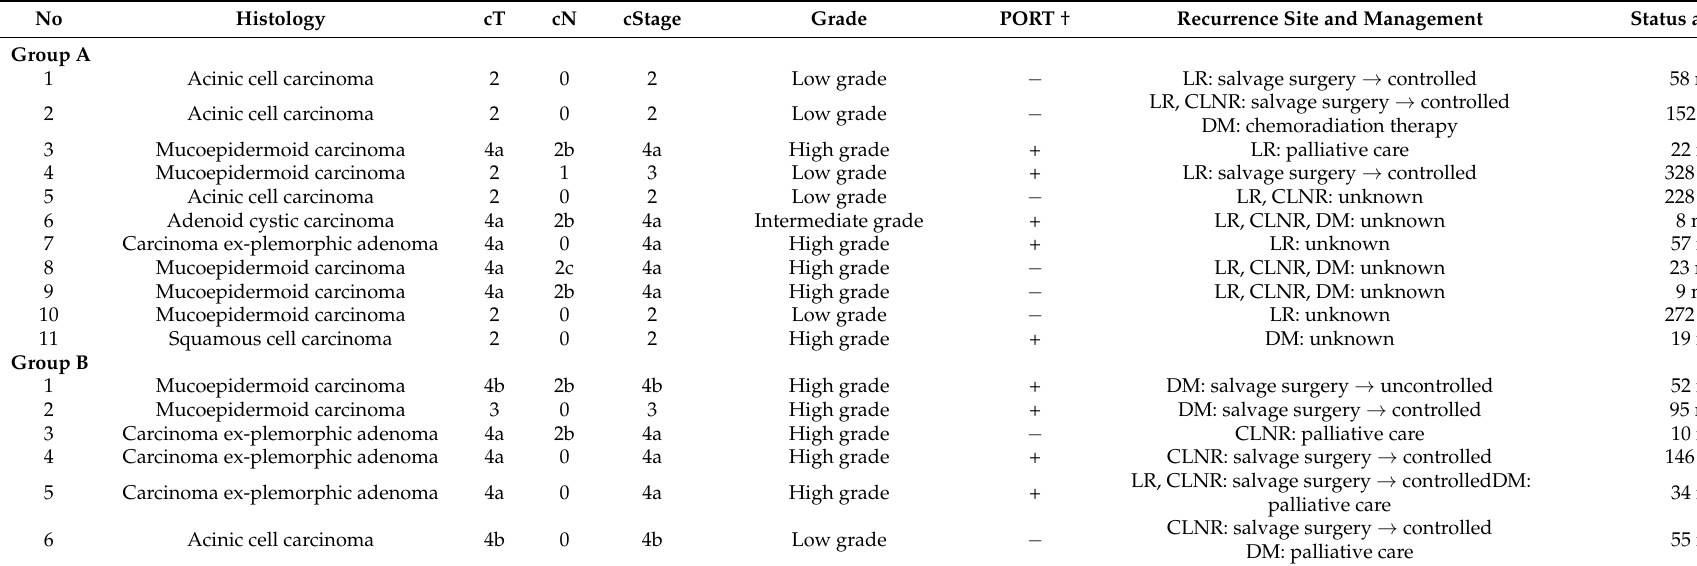
Table 4. Recurrence